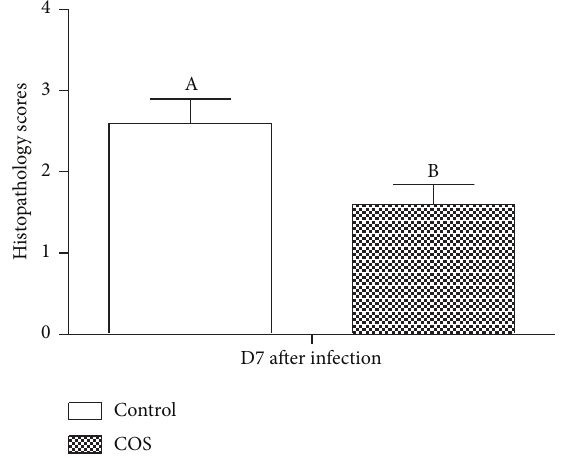
Figure 2: D7 postinfection histopathology scores of each mouse ( 𝑛 = 10 ).